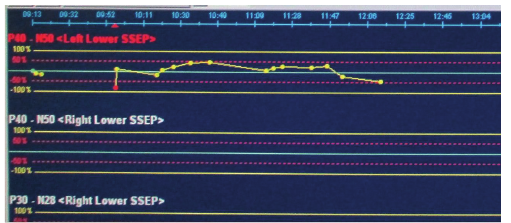
Figure 4: Deterioration of SSEP monitored at 11:47–12:00 PM.